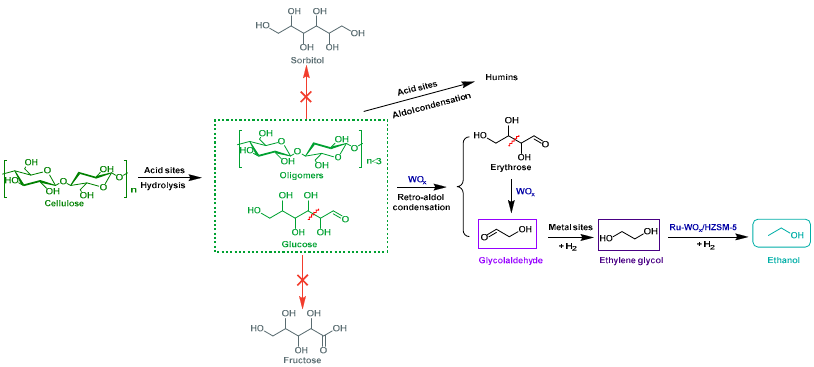
Figure 5. The proposed mechanism for conversion of cellulose to ethanol in one pot with Ru- WO x /HZSM-5 as a catalyst. WO x /HZSM-5 as a